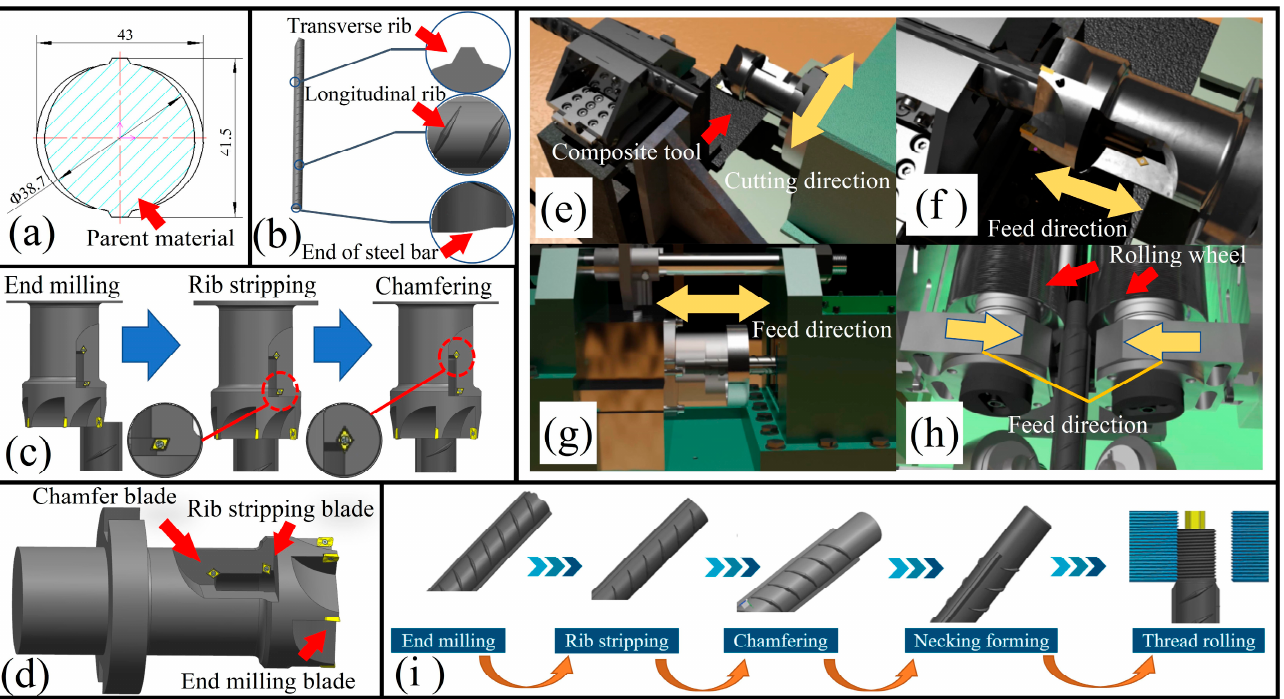
Figure 1. Technical process of machining. ( a ) Workpiece section diagram. ( b ) External surface of steel bar. ( c ) Machining process of the composite tool. ( d ) Composite tool model. ( e ) Process of face milling. ( f ) Process of rib stripping and chamfering. ( g ) Process of necking formation. ( h ) Process of thread rolling. ( i ) Changes process of steel bar.